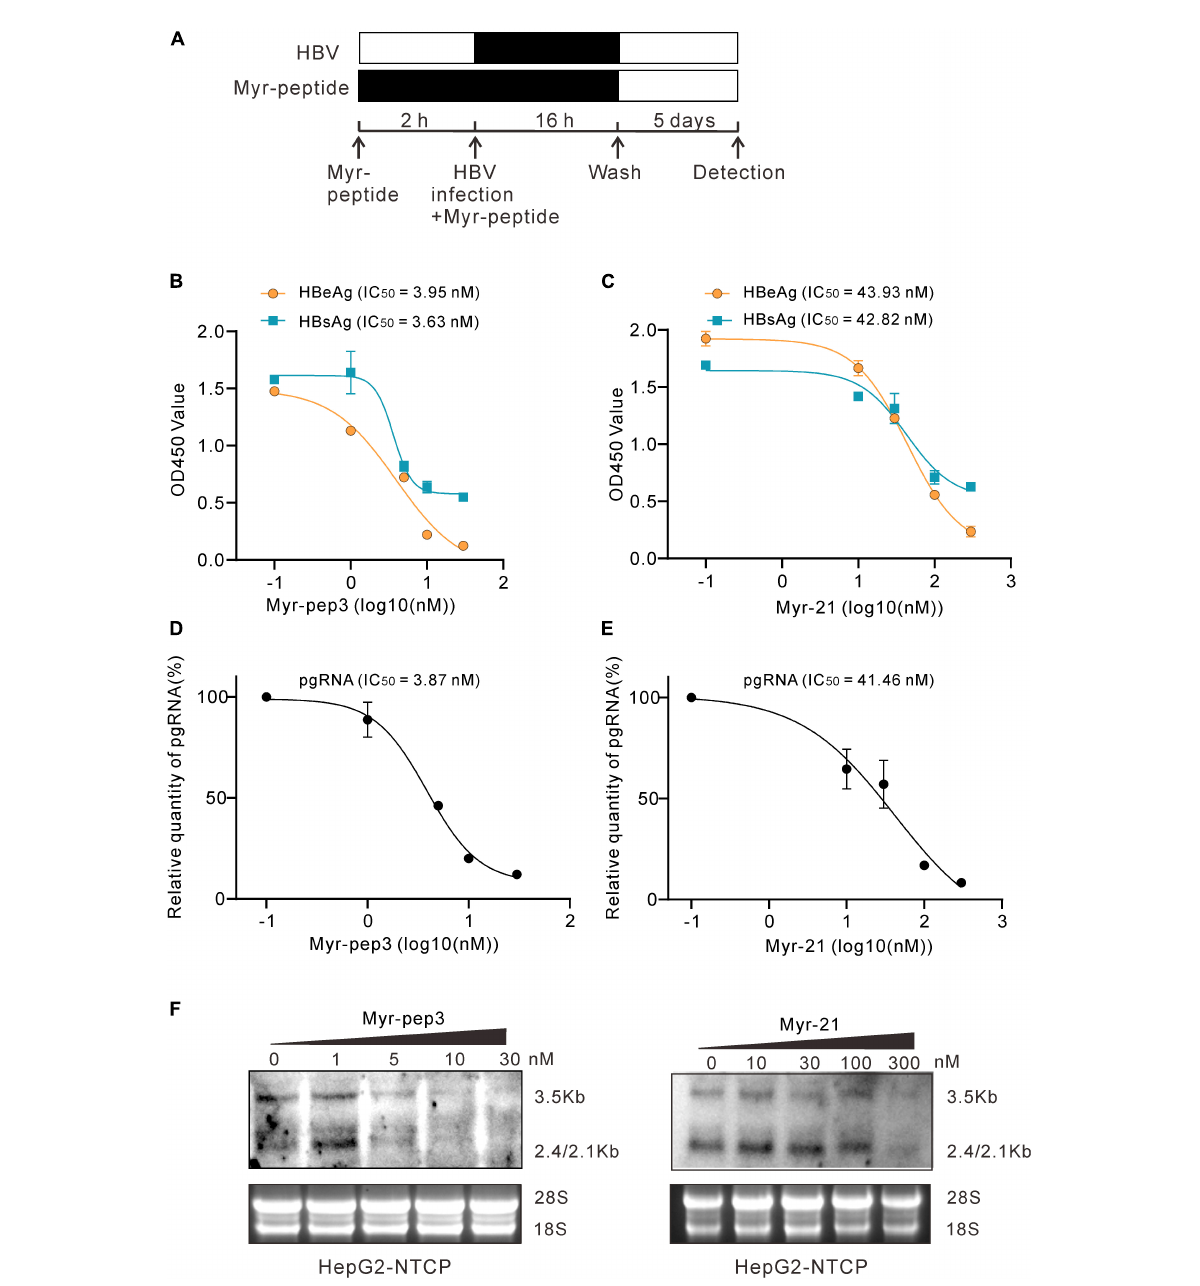
FIGURE5 Evaluation of preS1-21-pep3 on HepG2-NTCP cell model. (A) Procedure for the testing of the Myr-peptides (Myr-pep3 or Myr-21) on HepG2-NTCP cell model. HepG2-NTCP cells were pretreated with the Myr-peptides for 2 h and then inoculated with HBV for 16 h. The final concentrations were 0, 1, 5, 10, and 30 nM for Myr-pep3, and 0, 10, 30, 100, and 300 nM for Myr-21. After washing out the free HBV and the Myr-peptides, the cells were cultured with the medium in the absence of Myr-peptide for additional 5 days. (B,C) Secreted HBeAg and HBsAg in the medium were detected by ELISA, and the IC50s were calculated from the dose-effect curves. (D,E) RT-QPCR assay for intracellular HBV pgRNA. Intracellular HBV RNA samples were extracted from the cells and HBV pgRNA was detected by QPCR after reverse transcription. (F) Intracellular HBV RNA assays by northern blot. A part of the intracellular HBV RNA samples from (D,E) were detected by the northern blot.